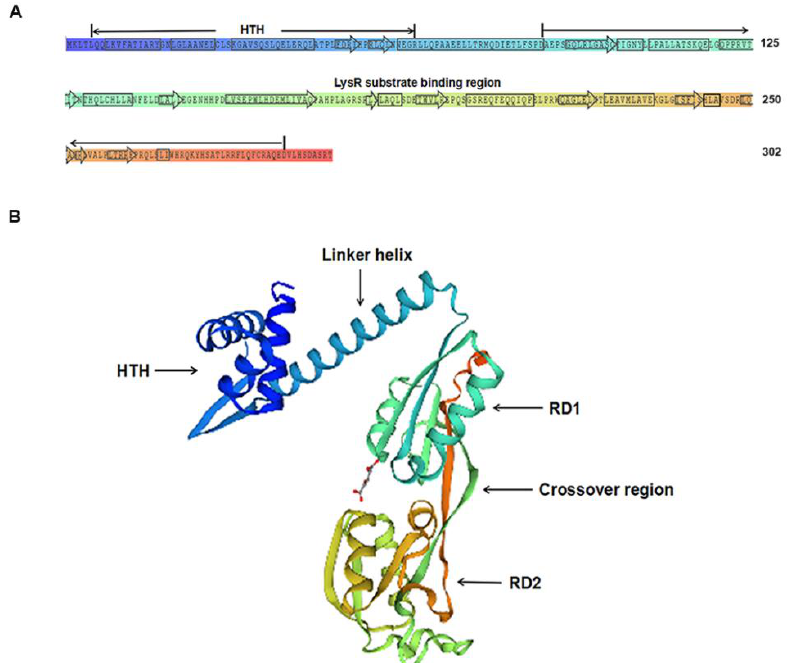
Figure 2. Structure of LahS protein. ( A ) Secondary structure of LysR family transcriptional regulator (LahS) protein. The N-terminal helix–turn–helix (HTH) domain and the LysR-substrate binding region were predicted using simple modular architecture research tool (SMART) software [23]. Rectangular box, α-helix; arrowheaded box, β-strand. ( B ) Predicted three-dimensional (3D) structure of LahS protein. The predicted maps were constructed with the SWISS-MODEL software [24]. Domains were shown in the corresponding position with the same colour coding, as in Figure 2A.